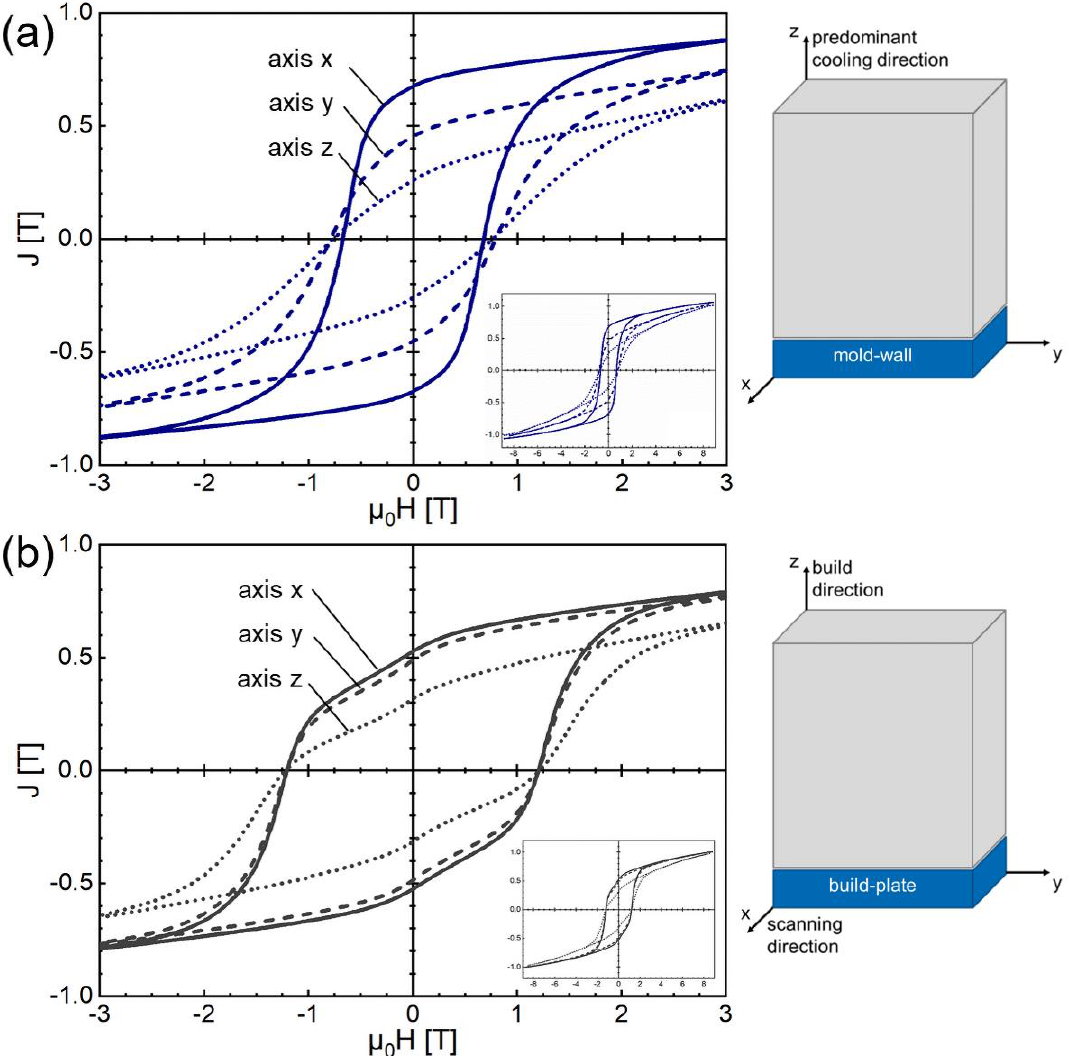
Figure 4. Room temperature hysteresis loops of ( a ) 3D-printed Fe73.8-Pr20.5-Cu2.0-B3.7 in the annealed state ( L-PBF-a ) and ( b ) BMC Fe73.8-Pr20.5-Cu2.0-B3.7 in the annealed state ( BMC-a ). The external magnetic field has been applied in three different directions (Cartesian coordinate system) as illustrated in the